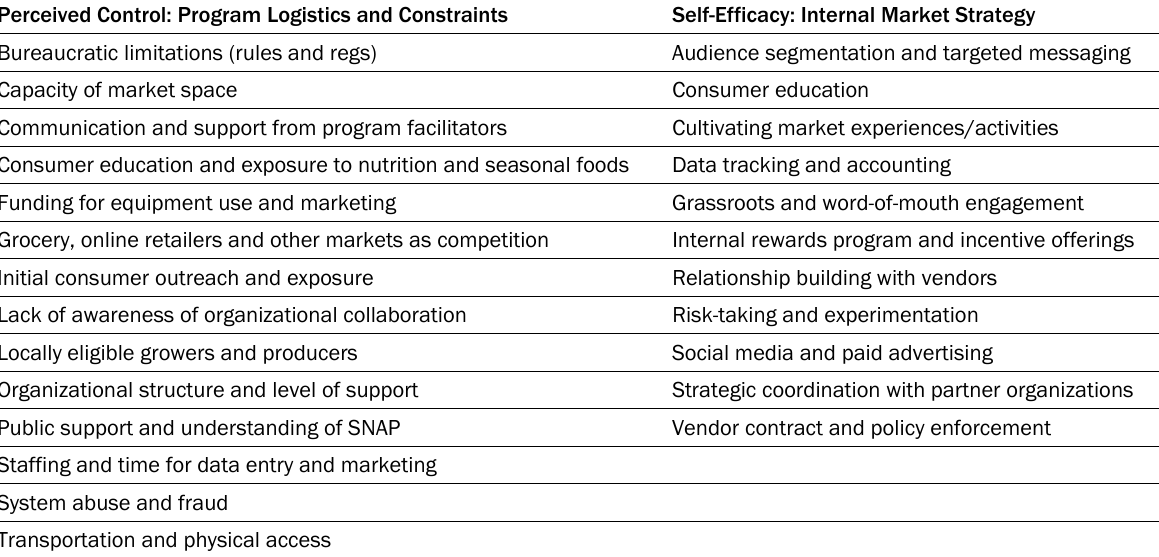
Table 1. List of Thematic Codes Relating to Objectives A and B Perceived Control: Program Logistics and Constraints Self-Efficacy: Internal Market